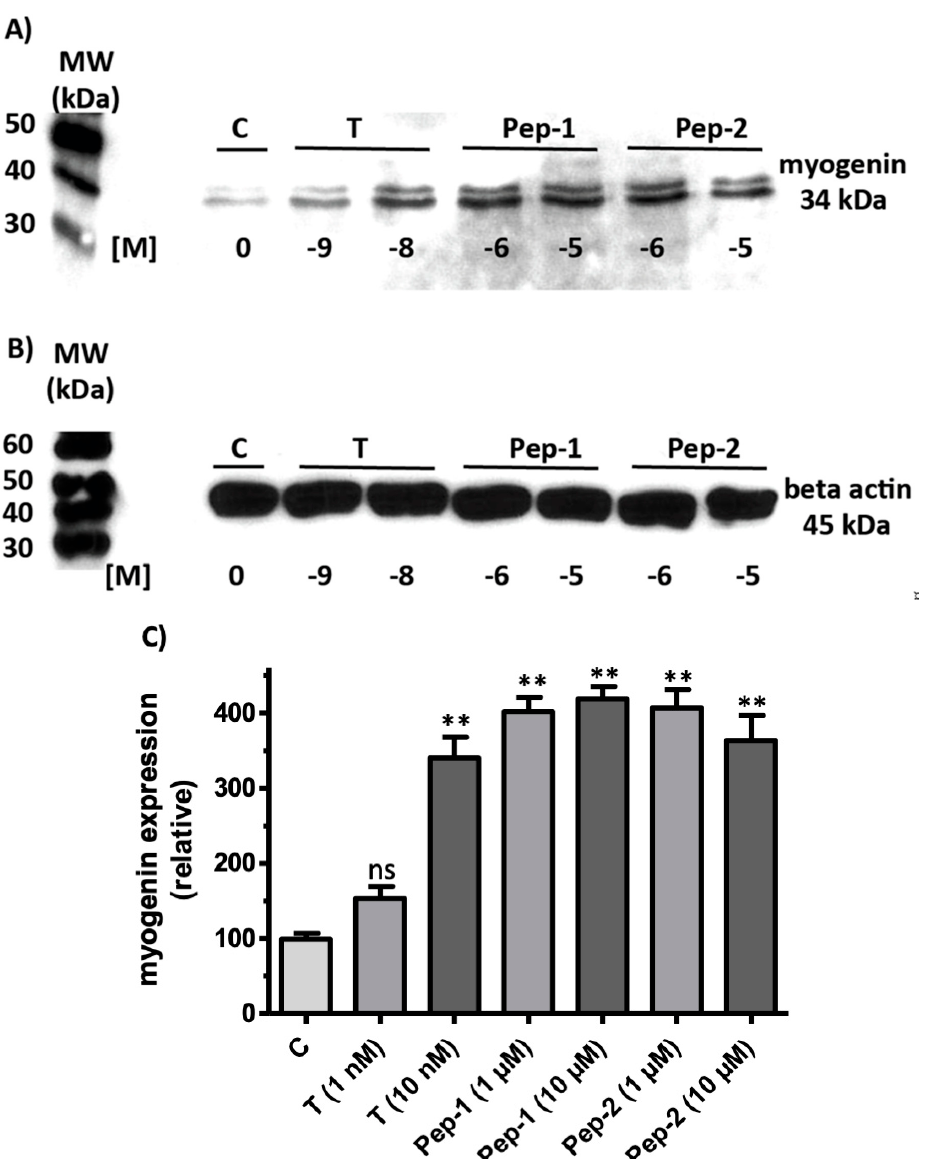
Figure 3. Detection of myogenin in western blots. Cell lysates were prepared from untreated L6 cells or from cells that had been exposed to different concentrations of testosterone, Pep-1, or Pep-2. ( A ) All androgenic compounds stimulate expression of myogenin. ( B ) The expression of beta-actin is not affected under any of the conditions applied. ( C ) Quantitative analysis of results as shown in ( A ). Data were corrected for (normalized to) the amount of beta-actin as shown in ( B ) ( n = 3; means ± SEM; ** p ≤ 0.001).